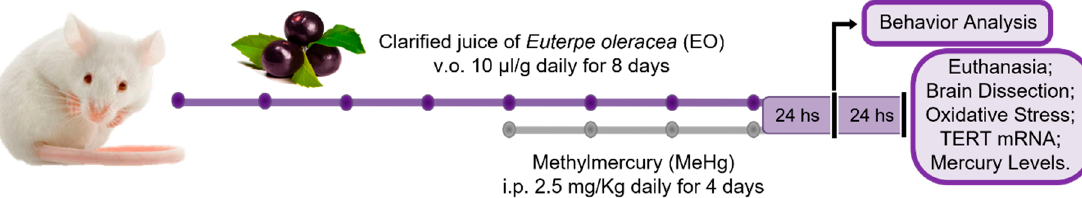
Figure 1. Experimental design . Adult male mice were treated with clarified juice of Euterpe oleracea (EO) or saline by gavage for 8 days. From the fourth day, animals also received intraperitoneally methylmercury (MeHg) or phosphate-buffered saline solution once